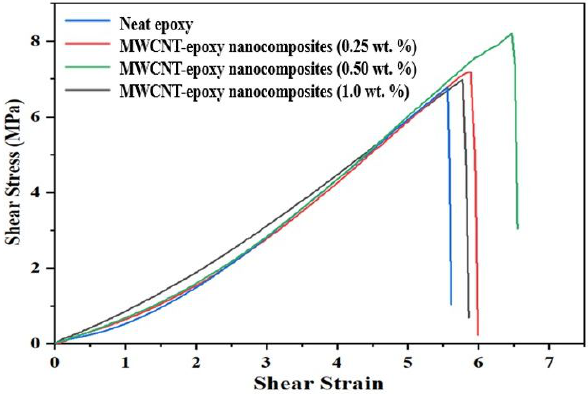
Figure 7: Lap shear strength of joints using neat epoxy and nanocomposites with different weight percentages of